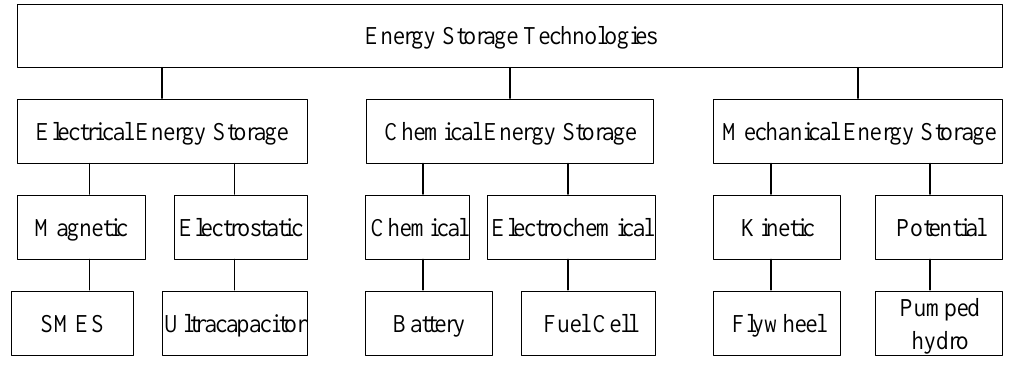
Figure 3. Energy Storage Technologies